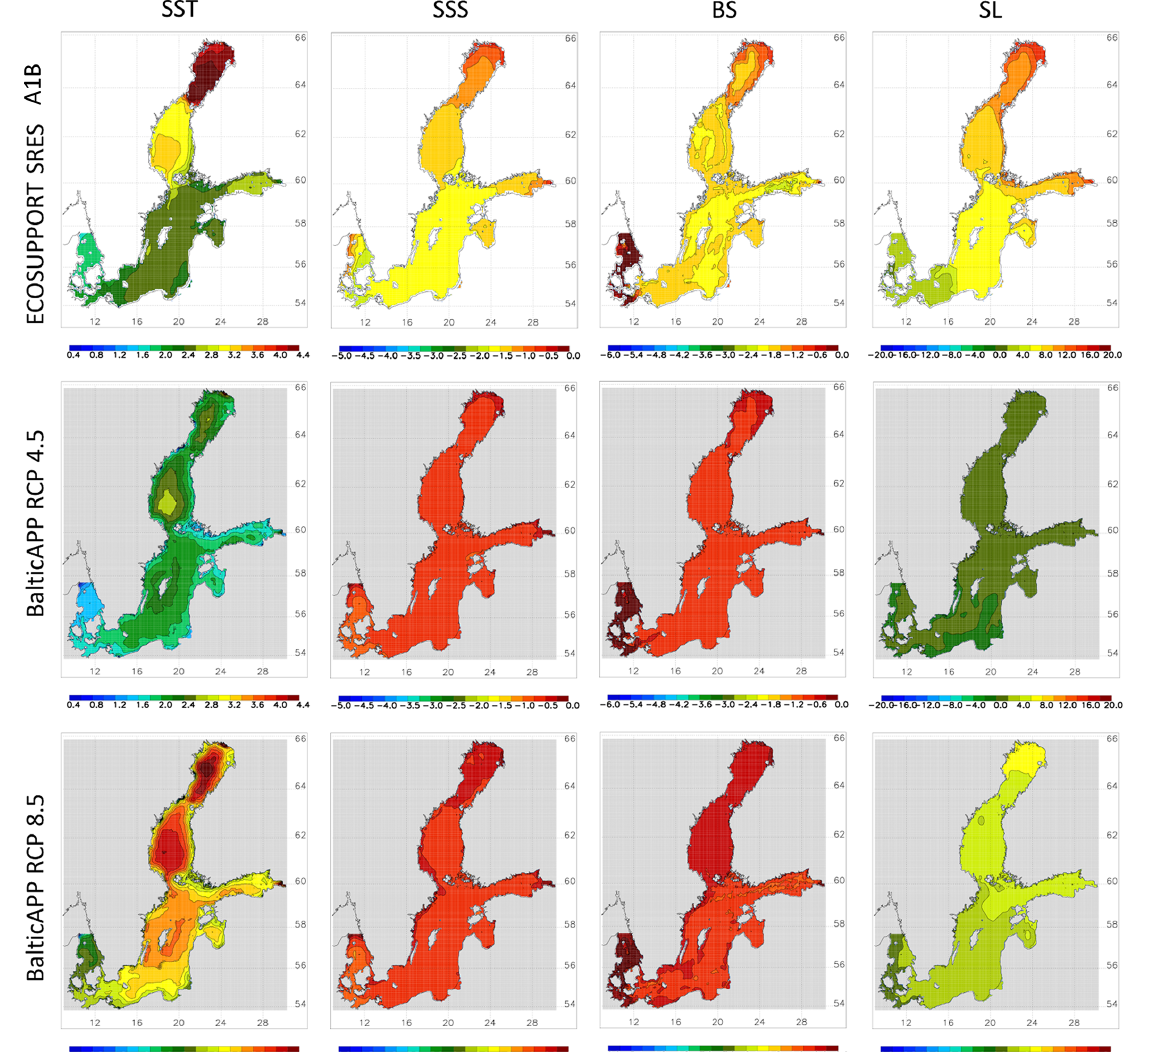
Figure 31. Shown, from left to right, are the changes in summer (June to August) mean sea surface temperature (SST; degrees Celsius), annual mean sea surface salinity (SSS; grams per kilogram; hereafter gkg − 1 ), and annual mean bottom salinity (BS; gkg − 1 ) and winter (December to February) mean sea level (SL; centimetres) between 1978–2007 and 2069–2098. From top to bottom, the results of the ensembles by Meier et al. (2011a; ECOSUPPORT), under the A1B/A2 greenhouse gas emission scenario (white background), and by Saraiva et al. (2019b; BalticAPP), under RCP4.5 (grey background) and RCP8.5 (grey background), are depicted. Source: Meier et al.,